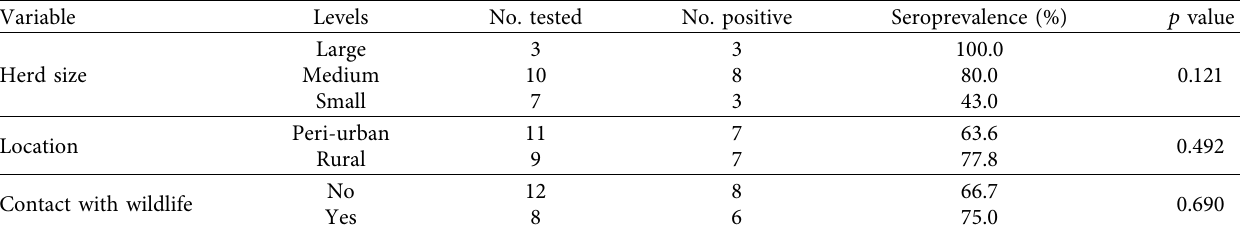
Table 2: Farm-level seroprevalence of brucellosis reported in 20 commercial dairy farms in selected districts of the eastern coast zone of Tanzania. Variable